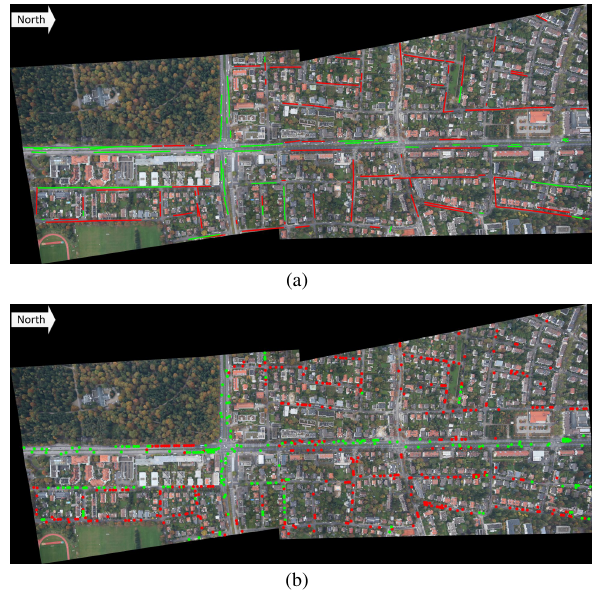
Figure 11. (a) Results for the separation of parking queues and traffic caused stopped queues, (b) Classification results of park- ing vehicles and traffic caused stopped